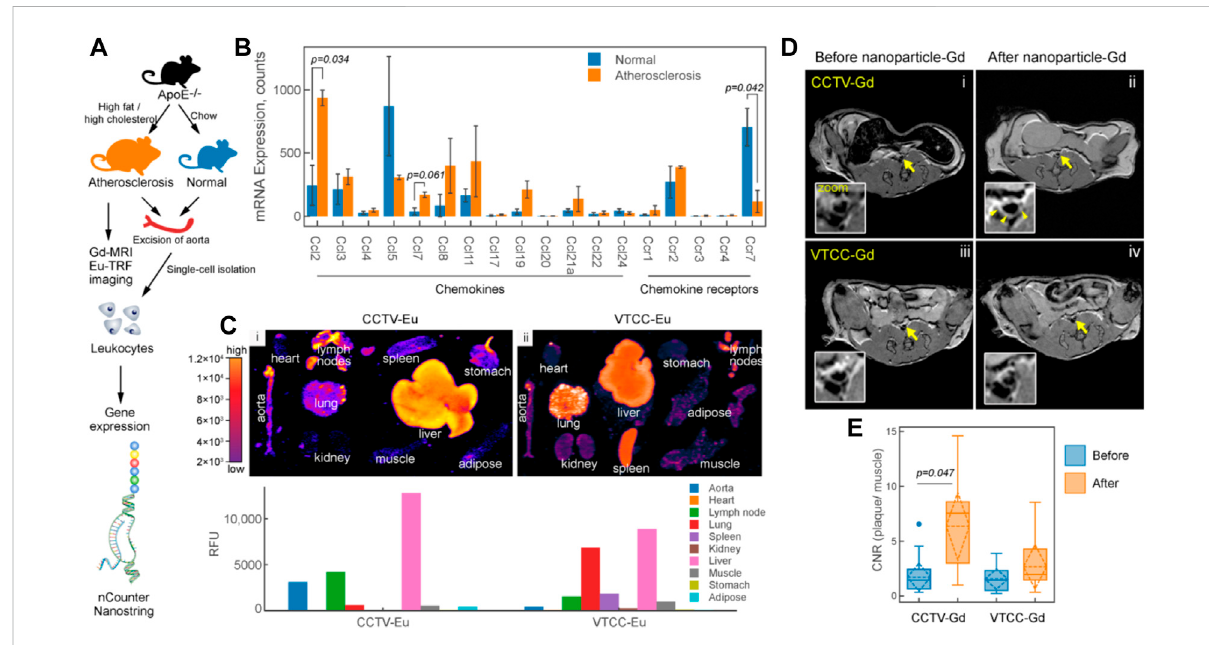
FIGURE 12 CCR2/CCL2 is highly expressed in atherosclerosis and a target for CCTV contrast agents. (A) Experimental work fl ow and generation of the atherosclerosis model. (B) nCounter Nanostring assays enabled quanti fi cation of mRNA expression of major chemokines and their receptors in leukocytes isolated from aortas of normal and atherosclerotic mice. (C) Europium (Eu)-enhanced time-resolved fl uorescence imaging (TRF) of excisedorgansfromatheroscleroticmiceinjectedwith0.1 mg/kg(basedonEuconcentration)ofCCTVorVTCCcontaining10%(byweight)Eu cryptate-conjugated lipids. (D) Magnetic resonance imaging of atherosclerotic plaque (arrows) with CCTV and VTCC containing gadolinium (Gd) lipid-conjugated chelates (DOTA) at 20% (by weight) and injected at 0.1 mg/kg (based on Gd concentration). (E) Contrast-to-noise ratio